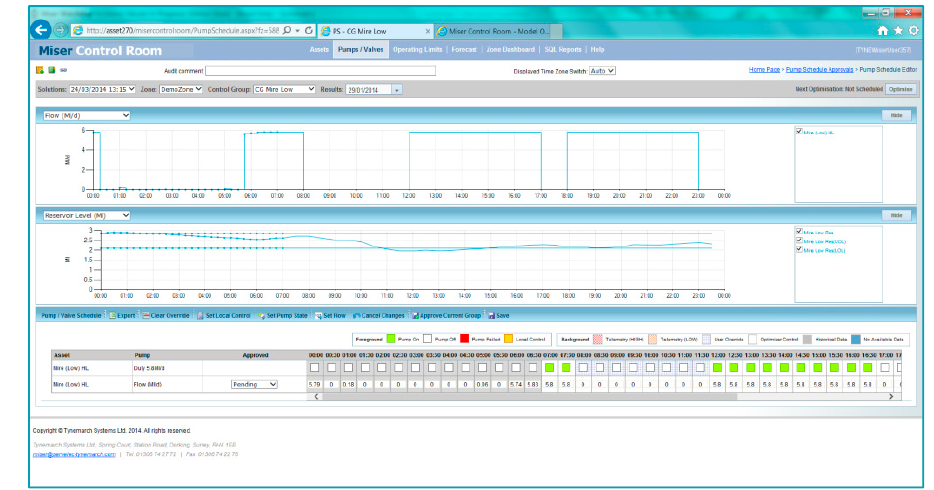
Figure 1. OptiMISER Schedule Editor